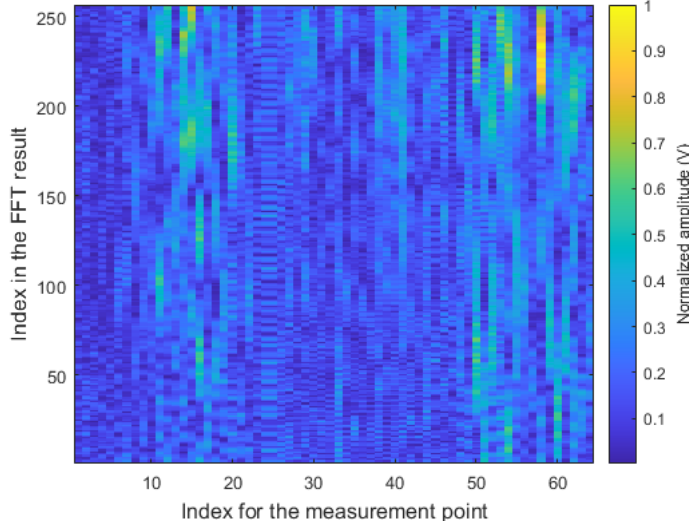
Figure 8. Fourier transform result of the radar sensor data acquired from all measurement points.